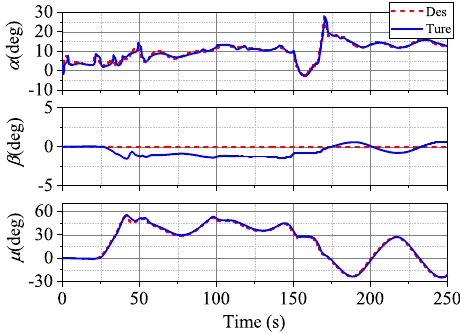
Figure 9. Results for α , β , and µ without